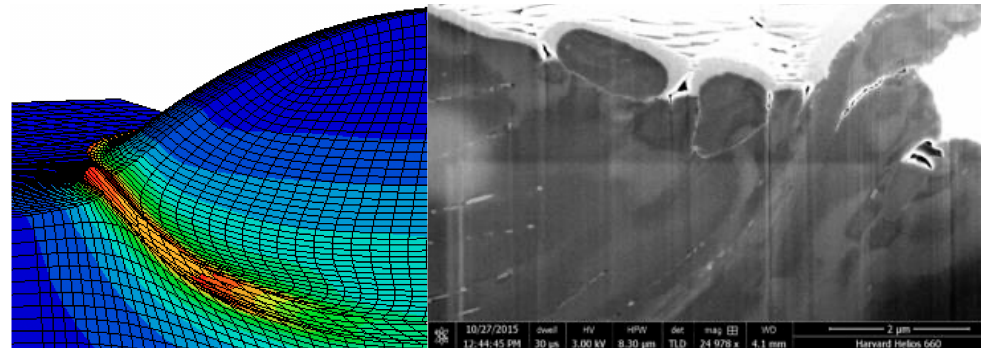
Figure 49. ( Left ) Finite element analysis (FEA) plastic equivalent strain plot from single particle impact analysis. ( Right ) Electron-based micrograph of the upper right corner of a cross-sectioned Al 6061 single particle deposit showcasing jetting at the particle / substrate interface.